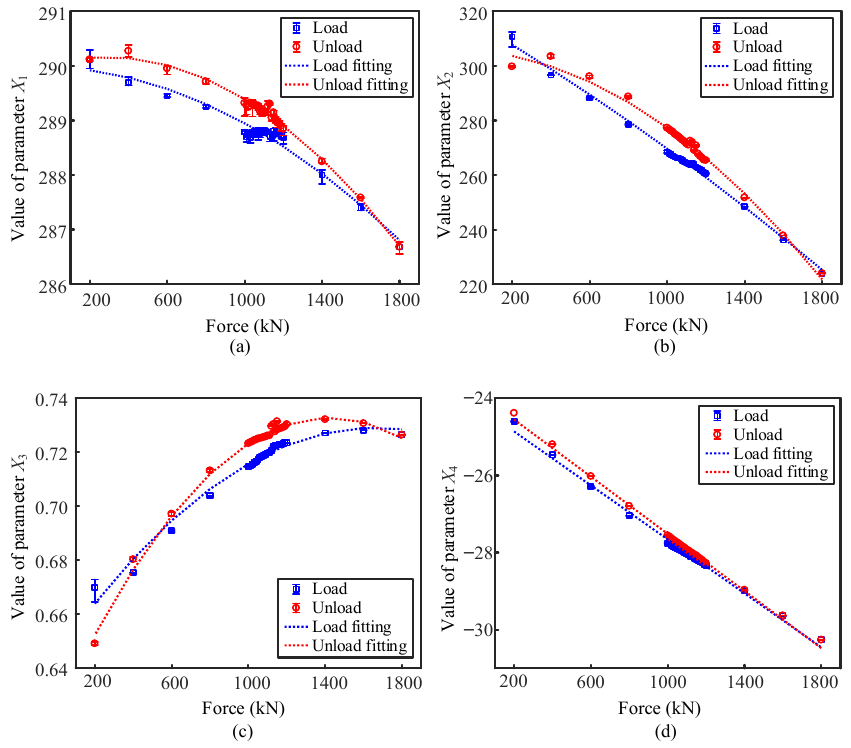
Figure 5. ( a – d ) Dependency of X 1 , X 2 , X 3 , and X 4 on the cable force, respectively.